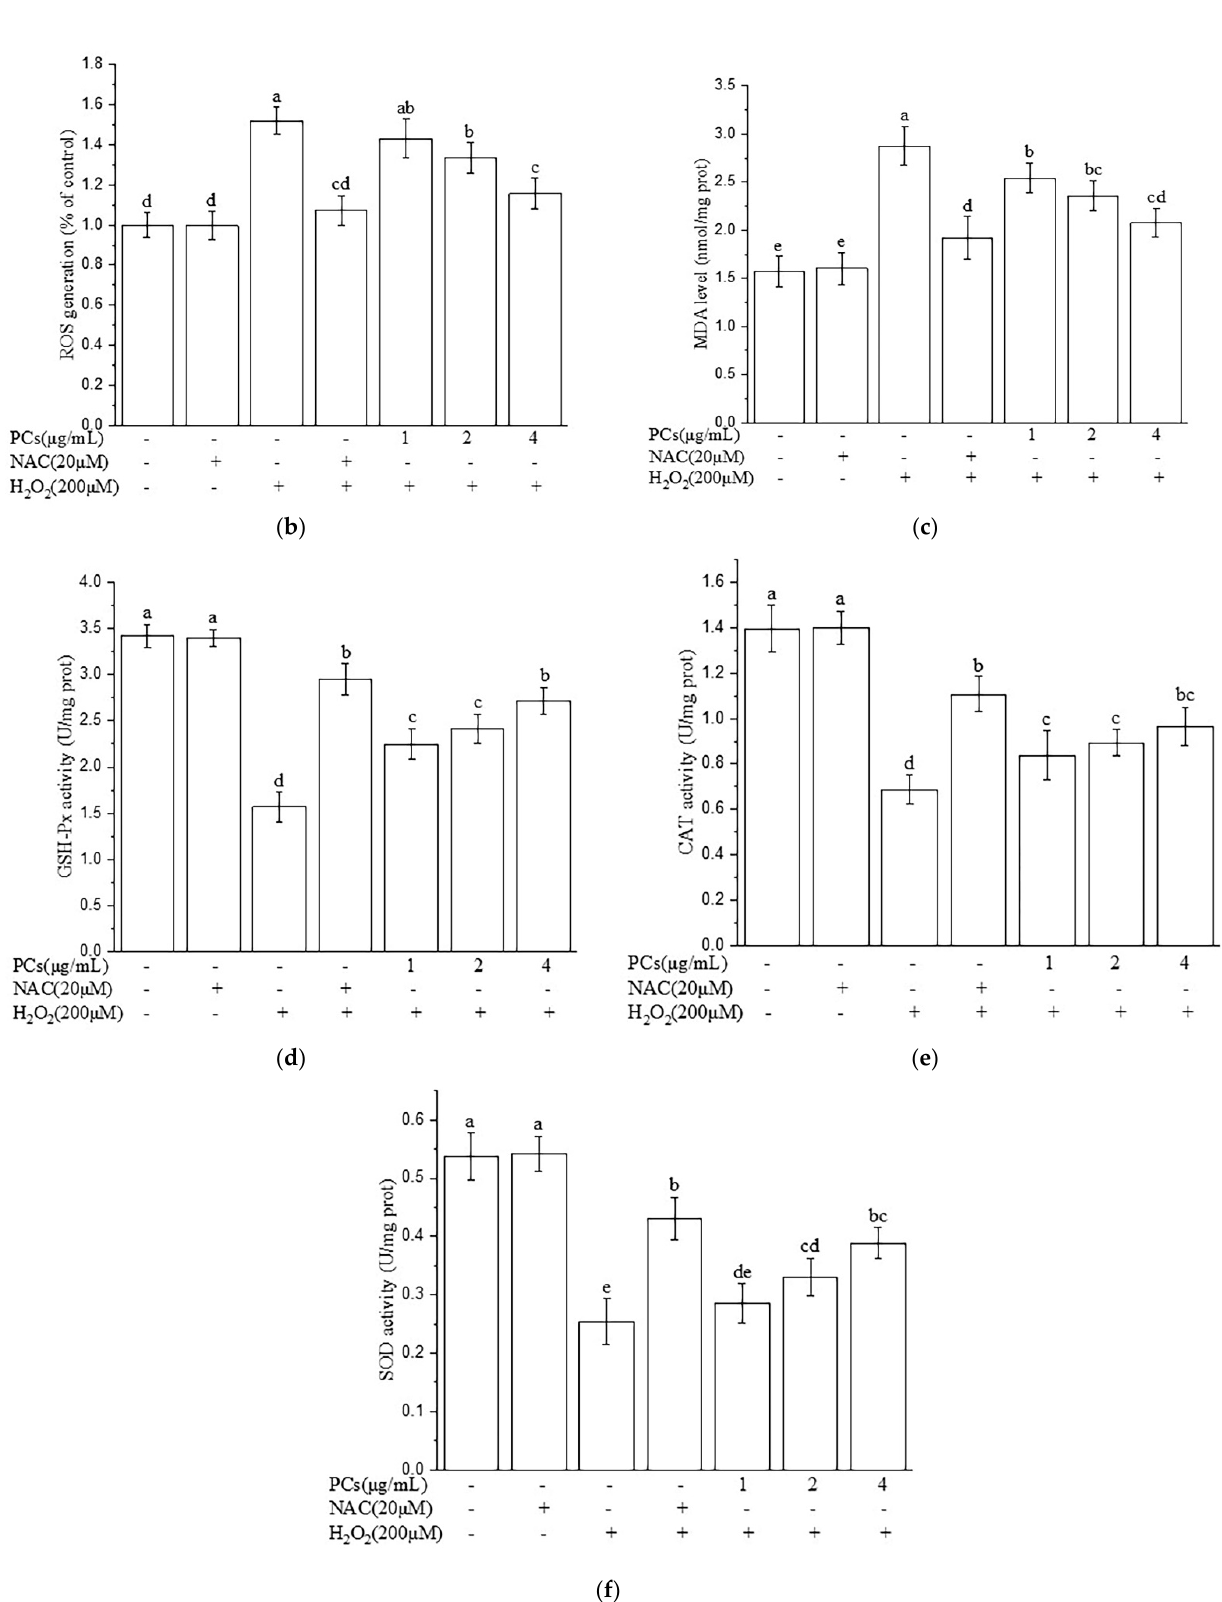
Figure 2. PCs attenuate H 2 O 2 -treated oxidative stress and increase antioxidant activities in PC12 cells. ( a ) Representative fluorescence photomicrographs of PC12 cells; ( b ) ROS levels were measured by software; ( c ) MDA levels; ( d ) GSH-Px activity; ( e ) CAT activity; ( f ) SOD activity. Data are expressed as the mean ± SD. All experiments were conducted three times. Values with different letters above are significantly different ( p < 0.05, one-way